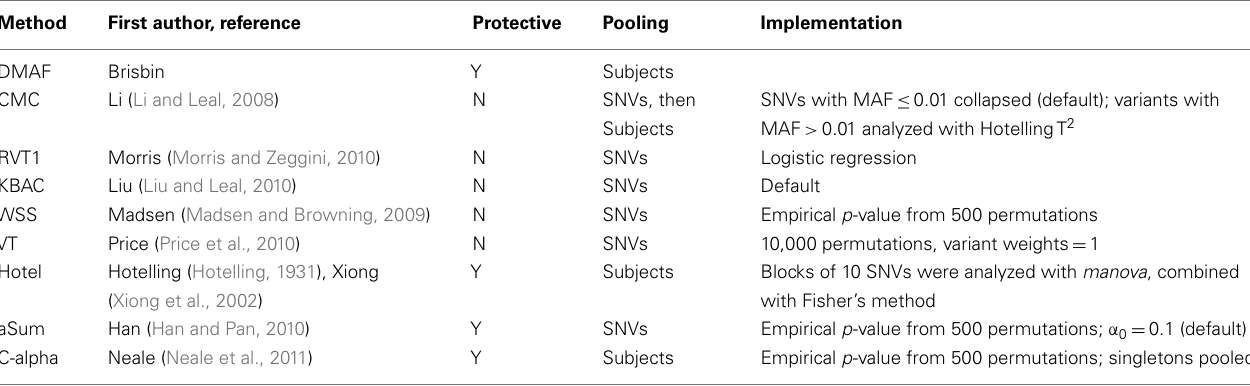
Table 3 | Rare variant association